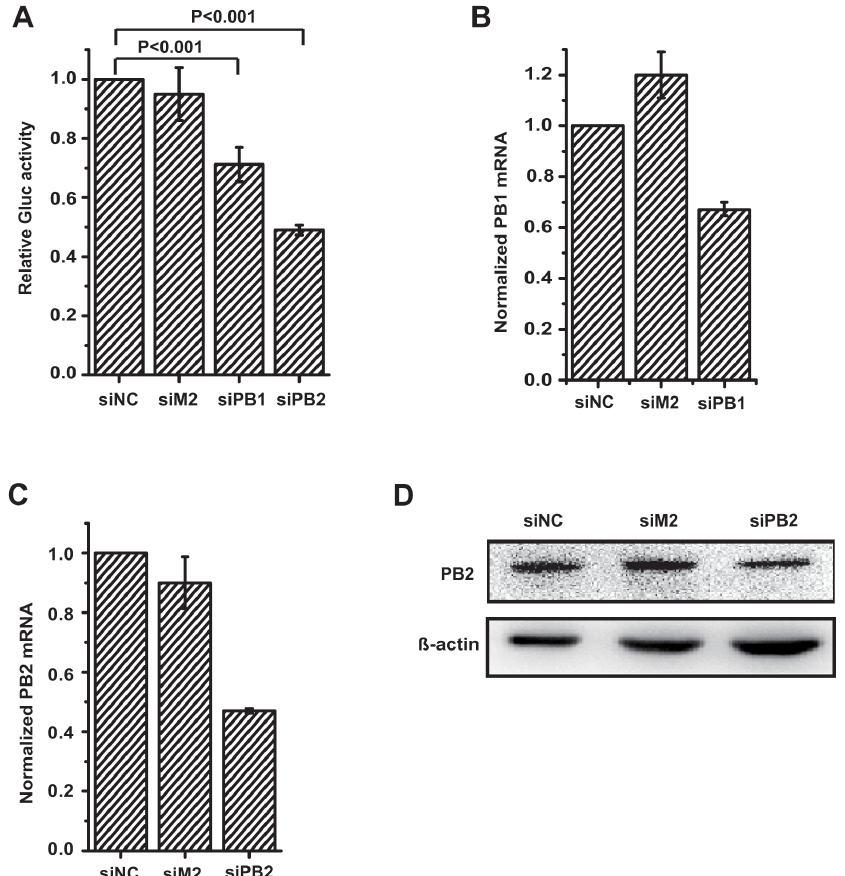
Fig 3. Effect of PB1 and PB2 knockdown on Gluc expression in A549-5Ps cells. A549-5Ps cells were transfected with 30nM negative control siRNA (NC), PB1 siRNA, PB2 siRNA and irrelevant control M2 siRNA, respectively, as described in materials and methods. At 72 hours post transfection, supernatants were replaced with fresh medium and cells were cultured for a further 24 hours. (A) Gluc activity in supernatants was quantified. Total cellular RNAs were extracted to quantify PB1 mRNA level (B) and PB2 mRNA level (C) by real-time RT-PCR. (D) The expression of PB2 was analyzed by Western Blot. Error bars standard error of the mean of four independent